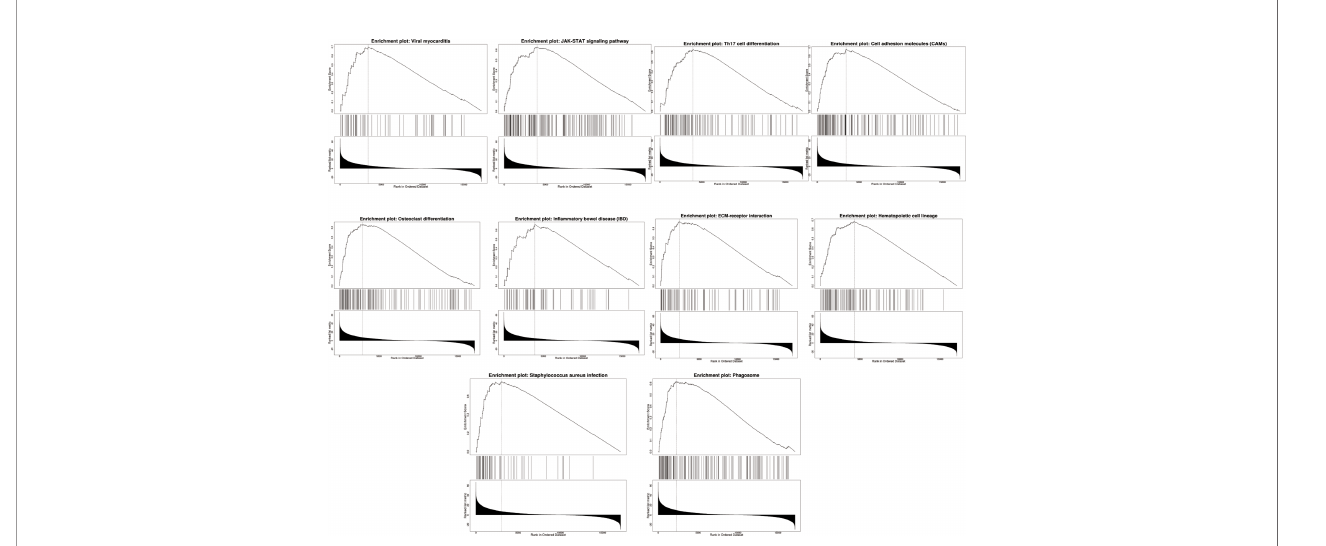
FIGURE 8 | Top 10 positively correlated GSEA enrichment plots.